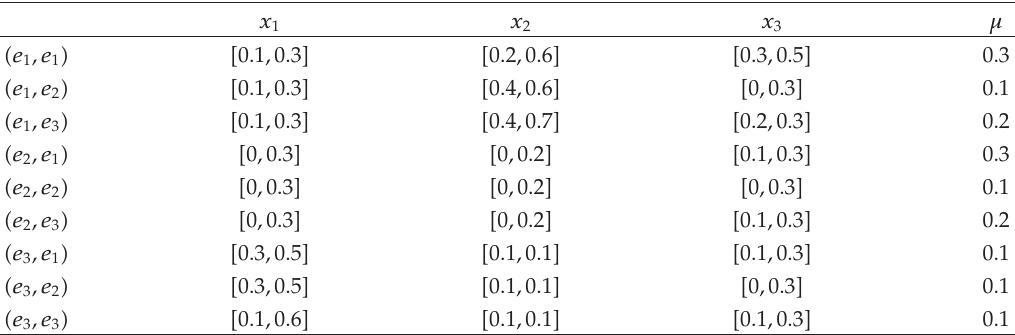
Table 1: (cid:4) (cid:25) H λ ,A × B (cid:5) .